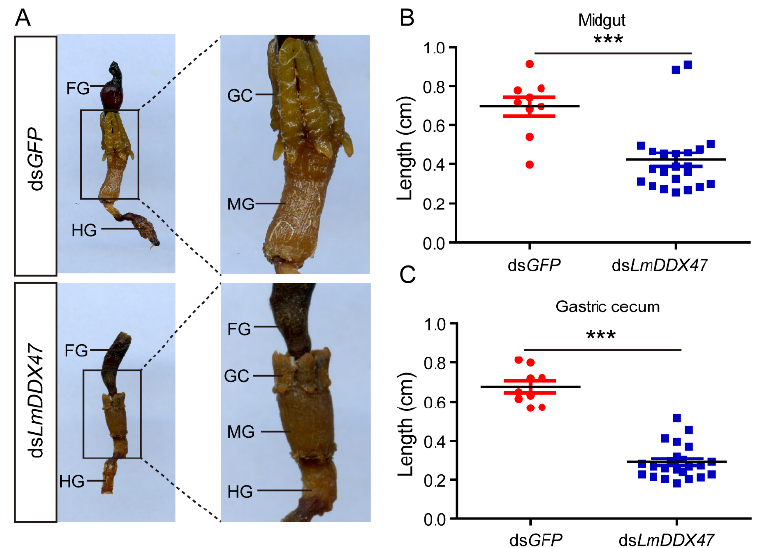
Figure 1. Effects of LmDDX47 on the intestinal tract of L. migratoria . ( A ) LmDDX47 knockdown led to atrophy of the midgut and gastric cecum. FG: foregut; GC: gastric cecum; MG: midgut; HG: hindgut. ( B , C ) Midgut length ( B ) and gastric cecum length ( C ) after LmDDX47 knockdown. *** p < 0.001.